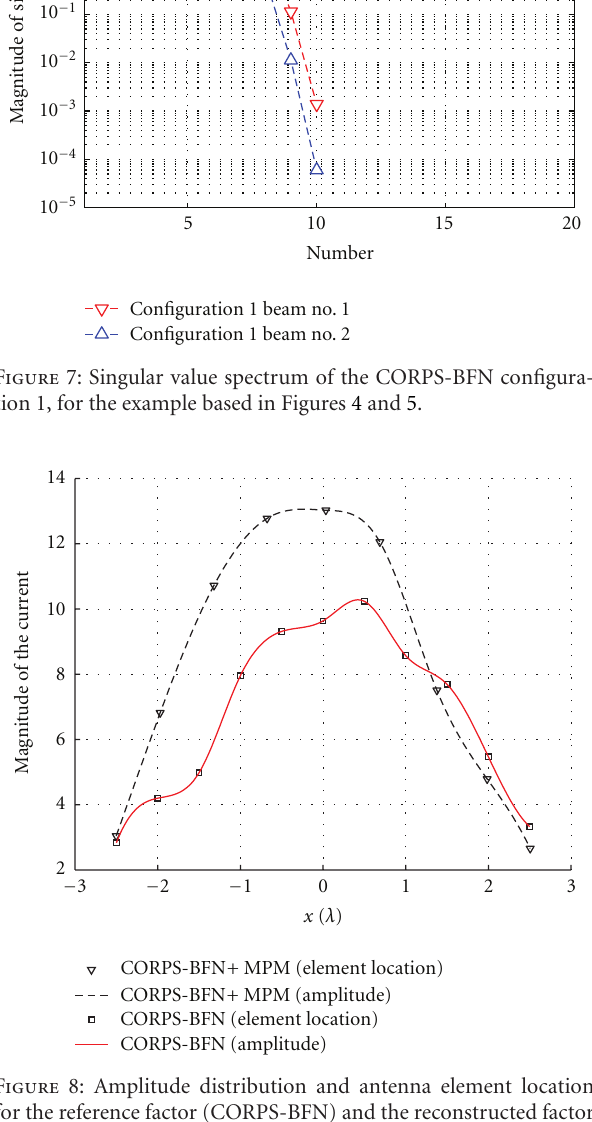
Figure 10: Behavior of the error ξ with respect to the direction of maximum gain for the configuration 1 of